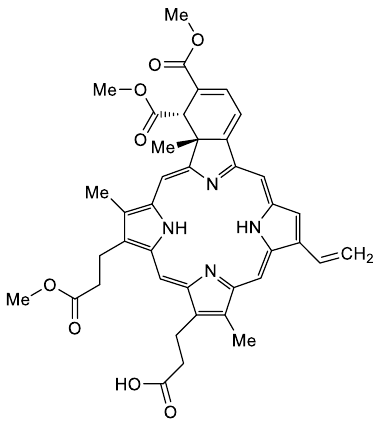
Figure 11. Structure of benzoporphyrin-derivative monoacid ring A (BPDMA).